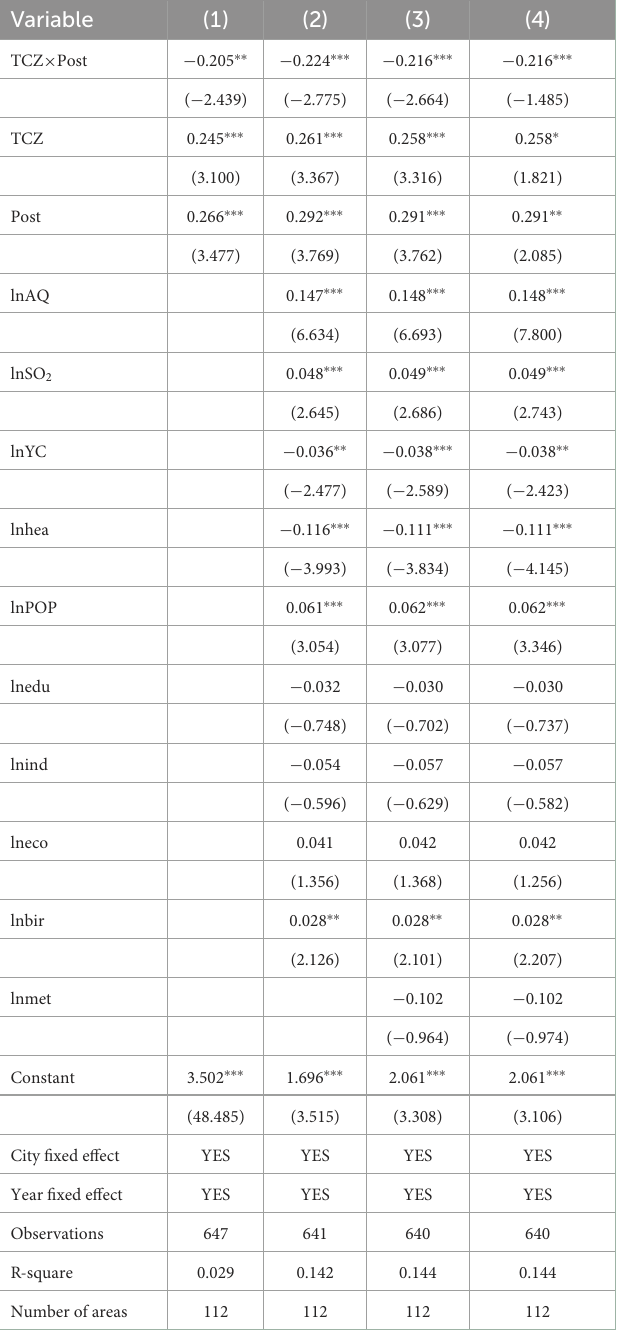
TABLE 2 Results of the benchmark regression. TABLE 3 Results of dynamic